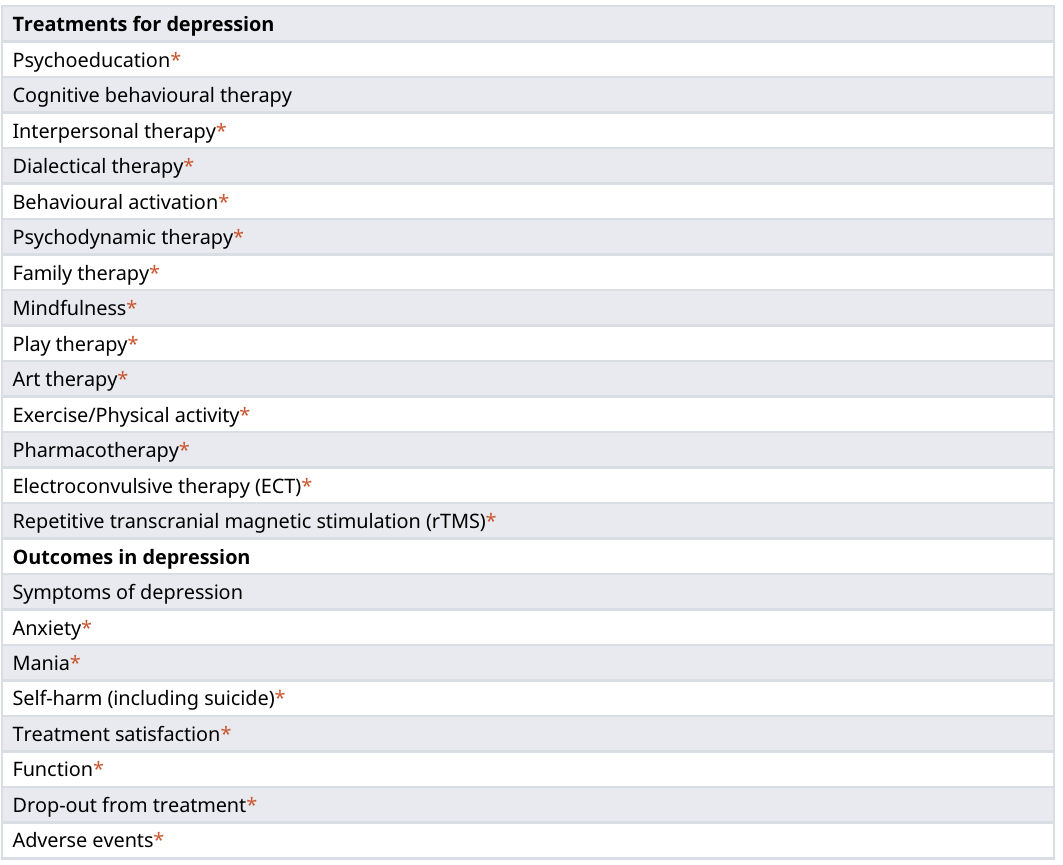
Table 2. List of treatments and outcomes of depression based on existing research** Treatments for